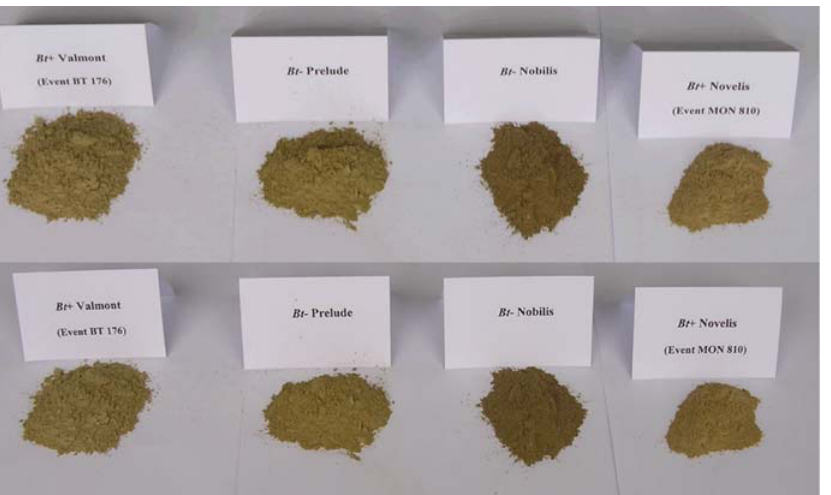
Figure 5. Examples of Amended Soils at the Beginning of the Experiment Some soil samples before entering the 1.0-L pots after the addition of crop residues (reaped maize straw, see Figure 1B). Please note the slightly different colors. DOI: